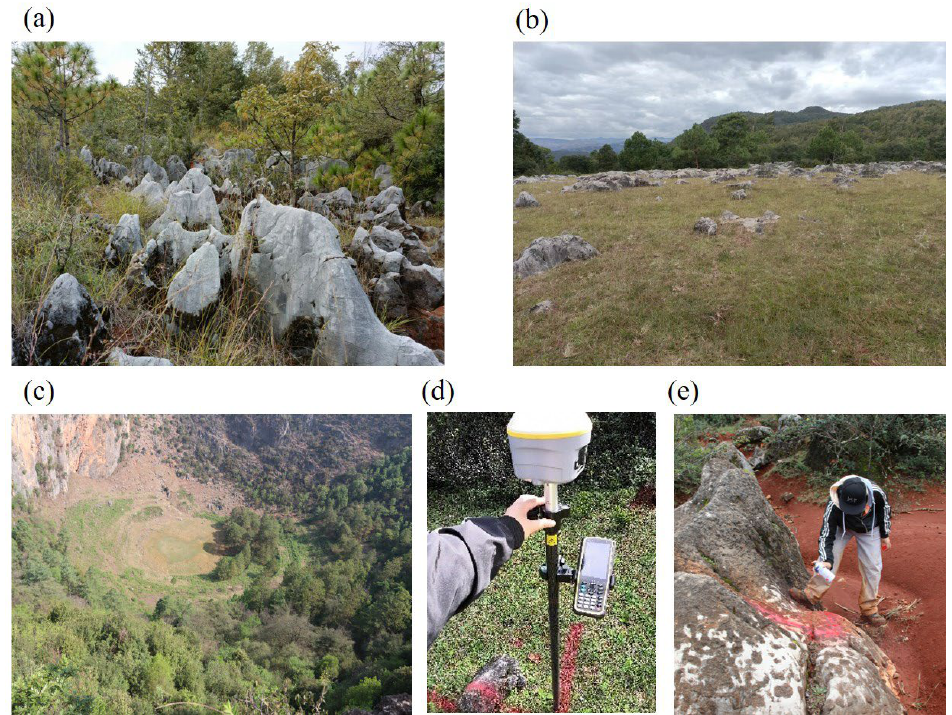
Figure A1. Photos of real scene. ( a ) Karst clints outside the tiankeng; ( b ) Karst land outside the tiankeng; ( c ) Shenxiantang tiankeng photo; ( d ) Acquire ground control points with RTK; ( e ) Ground control point marking photo.